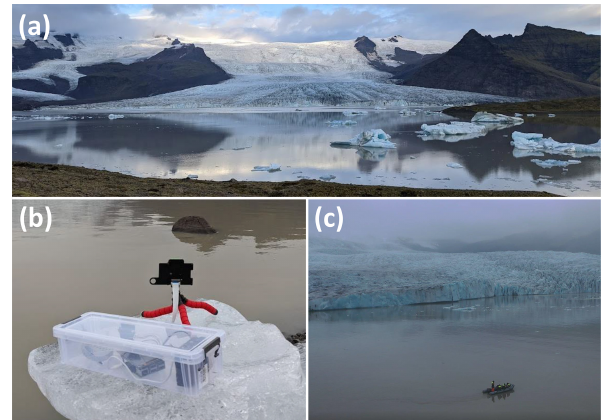
Figure 2. An overview of our data acquisition. (a) Fjallsjökull, lead- ing into Fjallsárlón, as of 17 September 2021. (b) Raspberry Pi on the shoreline survey. The camera was stabilized with a small tripod, with hardware and batteries connected in a weatherproofed recep- tacle. (c) Boat survey, approximately 500m from the glacier front, as captured by the